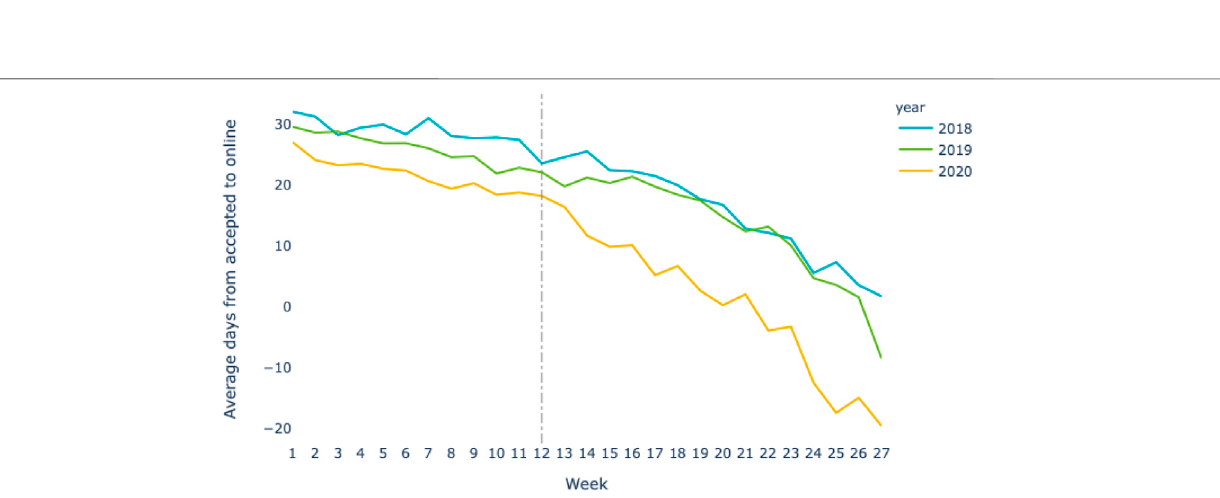
Frontiers in Research Metrics and Analytics |